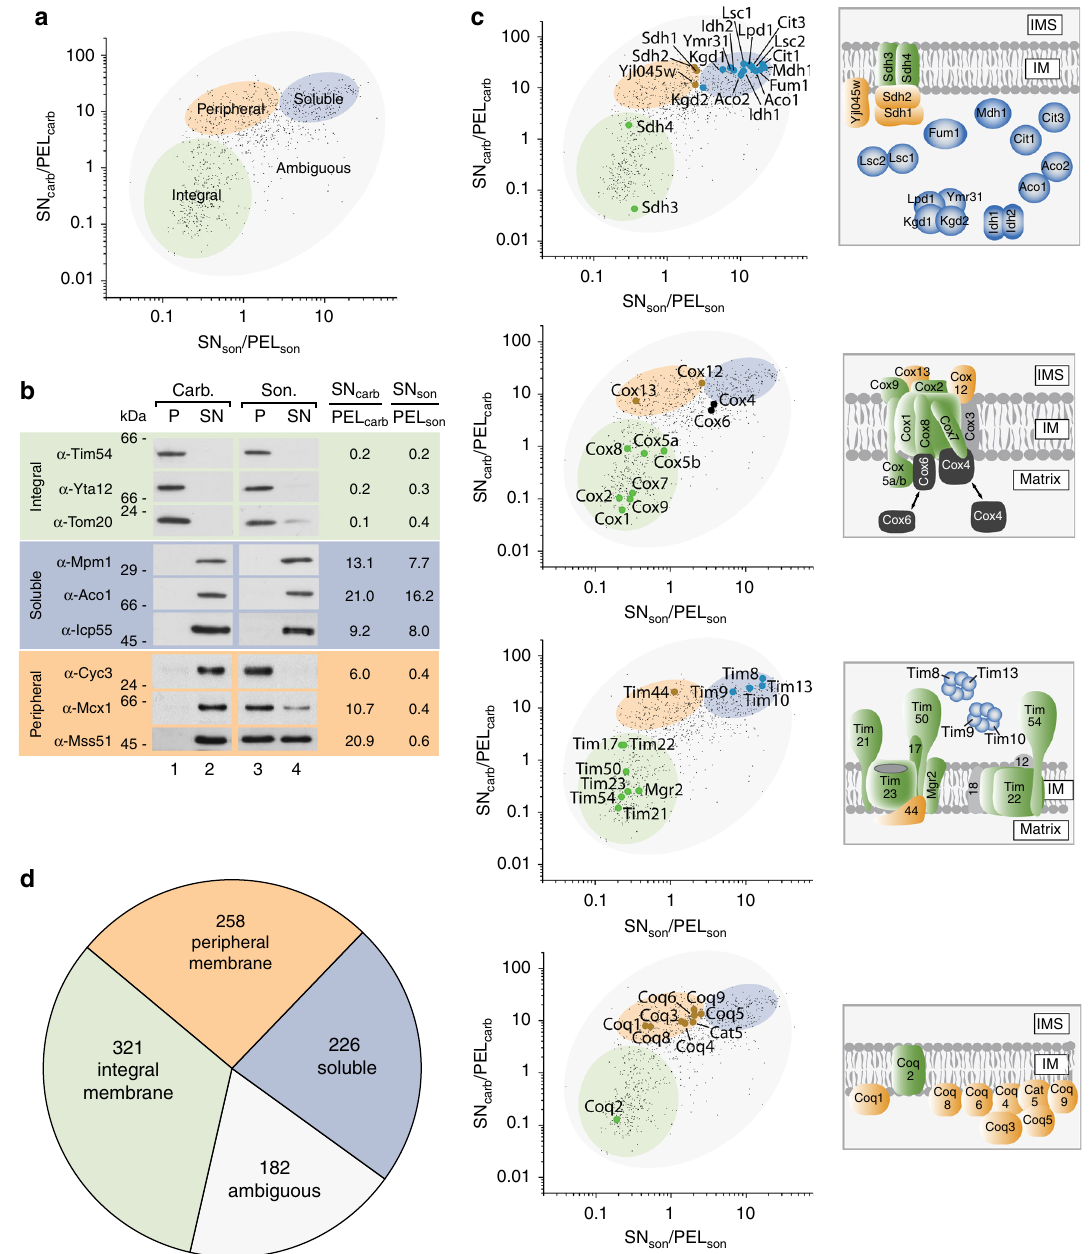
Fig. 2 Mapping of mitochondrial proteins into different classes. a Separation of the mitochondrial proteome into an integral membrane, a peripheral membrane, a soluble, and an ambiguous fraction. b Validation of map positions for several mitochondrial proteins by immunoblotting. c Map data correlation with known submitochondrial localization of components of the translocase of the inner membrane ( TIM ), the citrate cycle machinery, complex IV of the respiratory chain, and the Coenzyme Q biosynthesis apparatus 5, 13, 24 – 26 . Proteins in gray could not be mapped by LC-MS. d Distribution of the mitochondrial proteome into the indicated